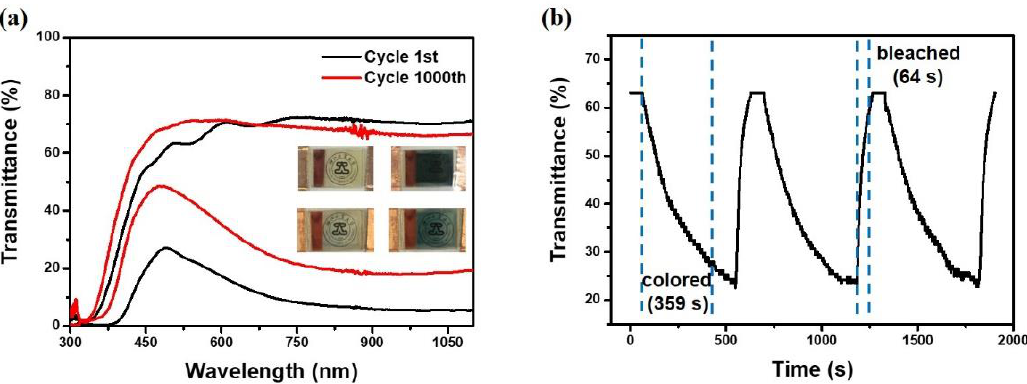
Figure 4. ( a ) The transmittance spectrum of the PECD in 300–1100 nm at the 1st cycle and the 1000th cycle; the insert corresponds to the 1st cycle bleaching and coloring state and the 1000th cycle bleaching and coloring state; ( b ) switching performance of the PECD at 529 nm.